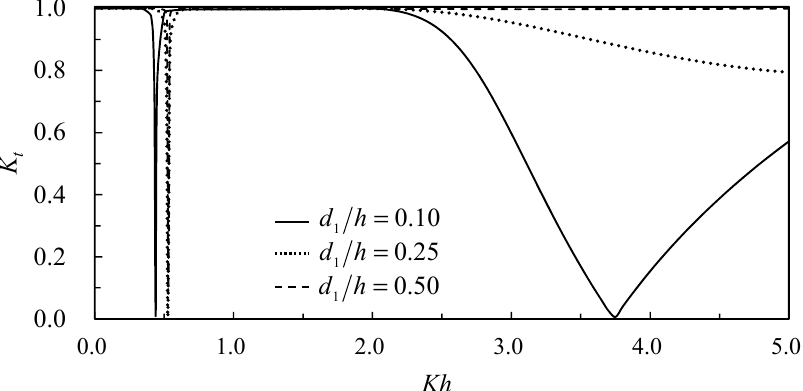
Figure 14. Transmission coe ffi cient versus relative water depth for various submerged depths of the